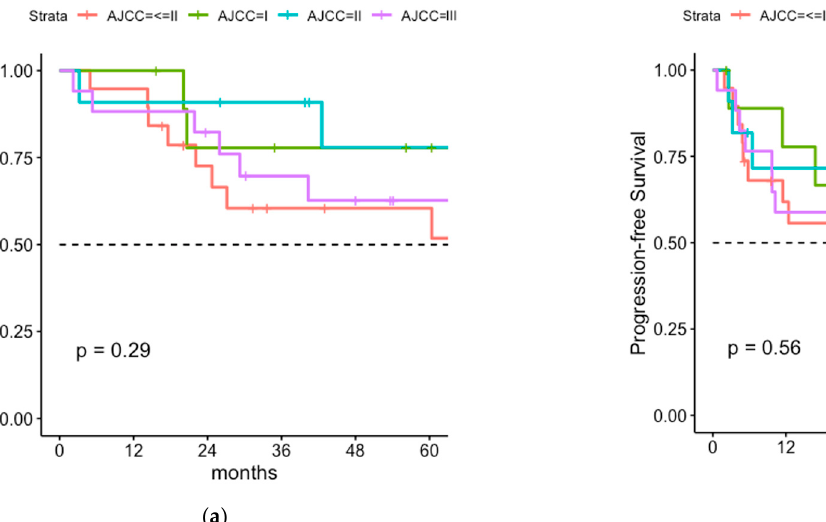
Figure A1. Stage adapted ( a ) OS and ( b ) PFS of the total cohort for stage I, stage II, stage ≤ II and stage II, according to AJCC-staging classification (n = 57).